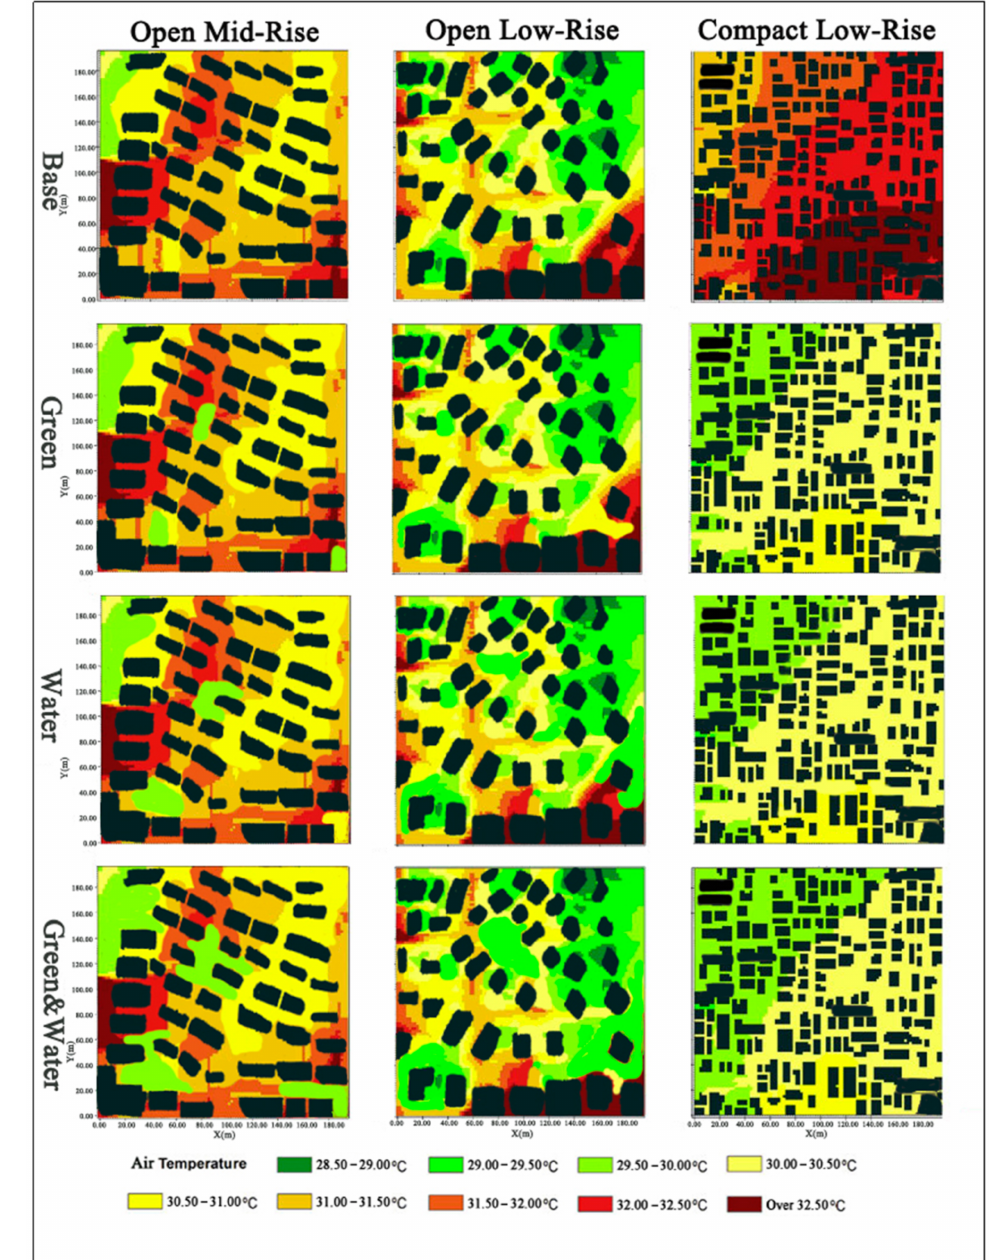
Figure 14. A 1.5 m surface temperature map of each mode at noon in summer (02:00